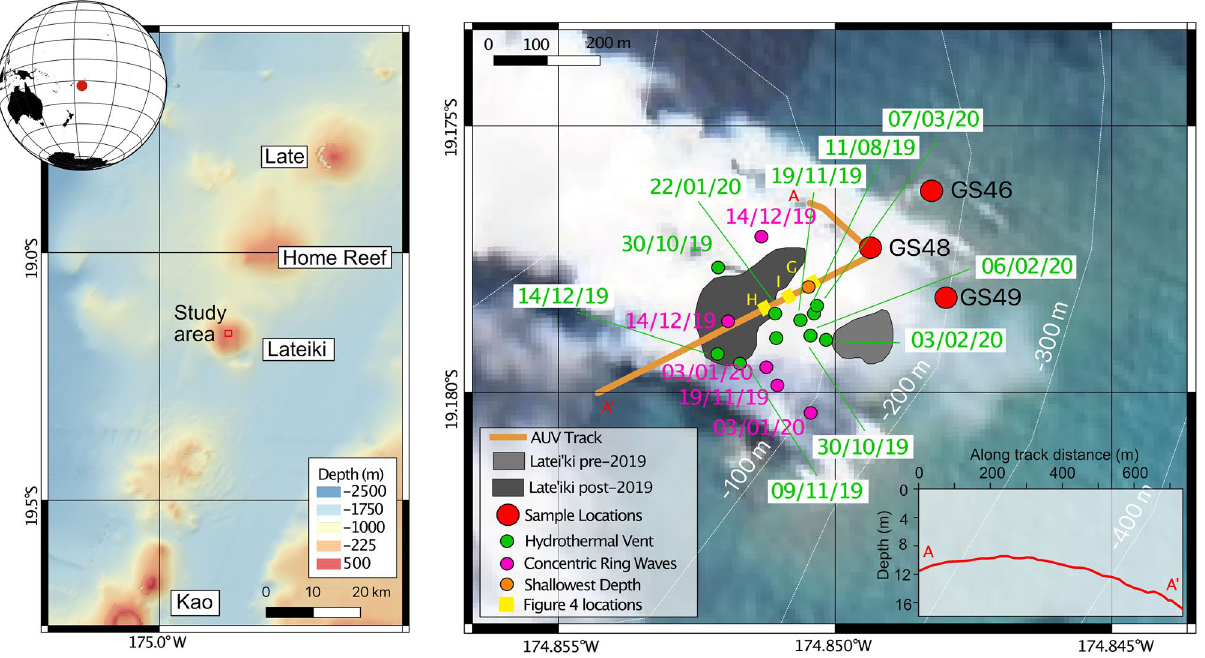
Figure 1. Late’iki location. Left hand panel shows the study area in its regional context. The bathymetry is reproduced from GEBCO Sheet G.08 compiled by R.L. Fisher of the Scripps Institution of Oceanography and extracted from the GEBCO Digital Atlas 58 . The right hand panel shows Sentinel-2 satellite imagery of the eruption site on the 20th October 2019 59 . Sampling locations and AUV track are plotted alongside locations of concentring ring waves and hydrothermal venting mapped from satellite imagery. The approximate locations of the photo mosaics from Fig. 4 are shown in yellow. The inset profile shows the water depths along the AUV track over the summit of Late’iki post eruption in February